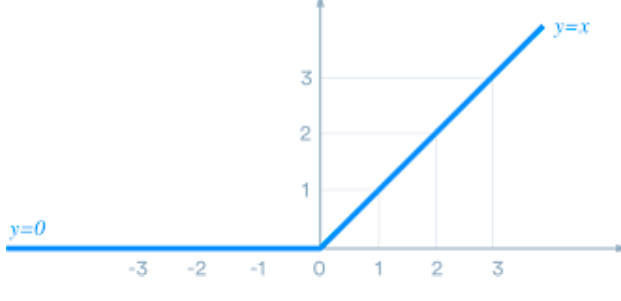
Figure 4. Leaky rectified linear unit.